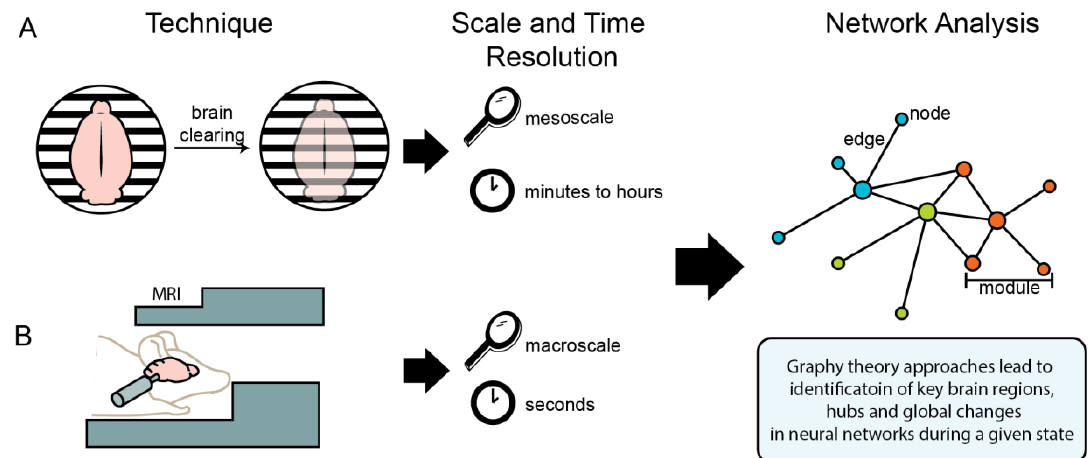
Figure 1. Illustration of imaging techniques used for neural network analysis of functional and structural brain connectivity. ( A ) Single-cell whole-brain imaging techniques, such as iDISCO, allow for analysis of the whole brain at the mesoscale (i.e., with region and cell-specific resolution), with results representing neural activity across minutes to hours. ( B ) Magnetic resonance imaging (MRI) techniques allow for analysis of the brain in more generalized resolution (i.e., at the macroscale) in anesthetized or immobilized animals, with results representing neural activity across seconds. Data from both of these methods can be interpreted using graph theory approaches to identify key brain regions, hubs, and global changes in neural networks during a given state.